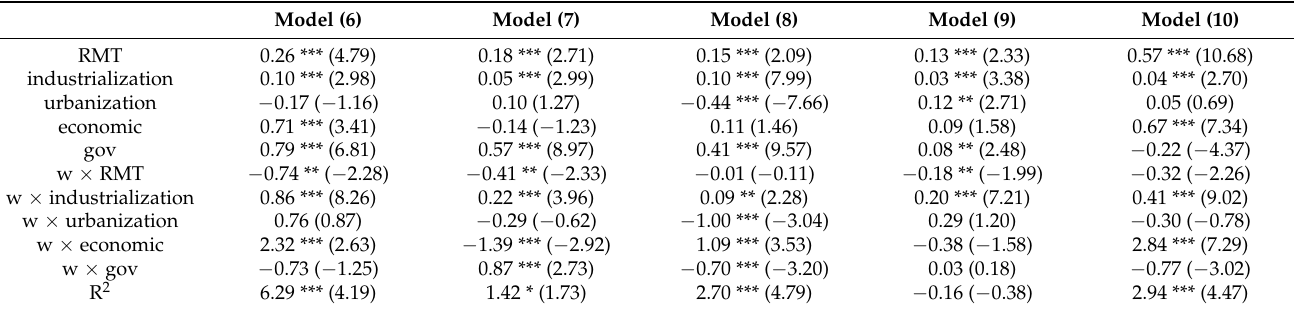
Table 2. Results of